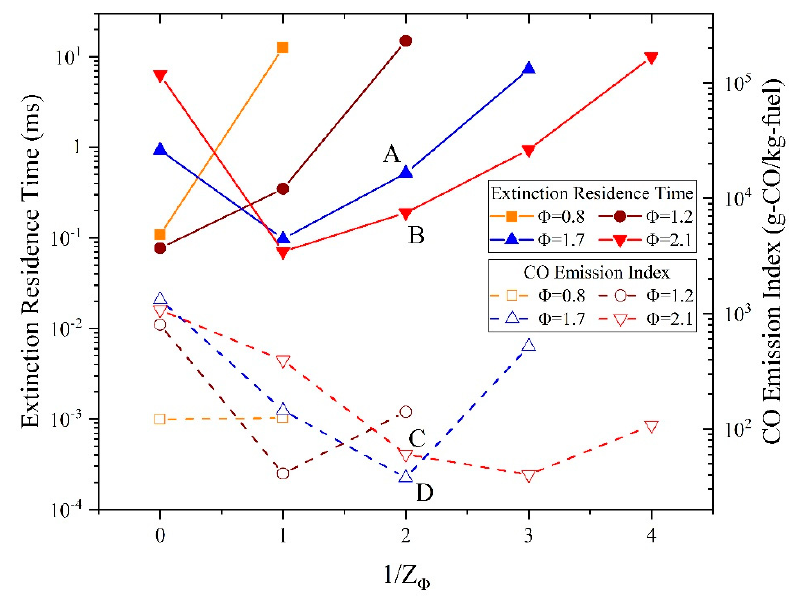
Figure 14. Comparison of the extinction residence times of air–light hydrocarbon mixing gas at the reciprocal of each mixing degree and the CO emission indices corresponding to the residence time of 20 ms.